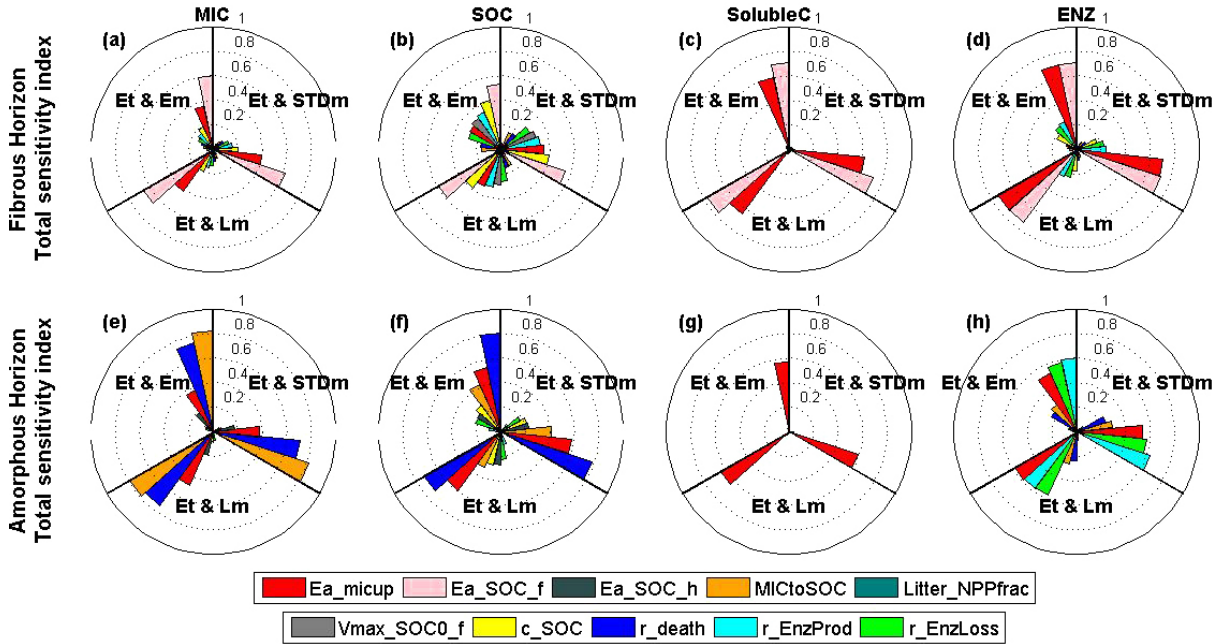
Figure 7. Coxcomb plot of Sobol’s estimates of total-order parameter sensitivity indices for microbial biomass (MIC), soil organic C (SOC), soluble C (SolubleC), and enzyme (ENZ) pools under three altered environmental scenarios: elevated temperature and standard moisture (Et and STDm), elevated temperature and elevated moisture (Et and Em), elevated temperature and lowered moisture (Et and Lm) for fibrous horizon (first panel, a–d ) and amorphous horizon (second panel, e–h